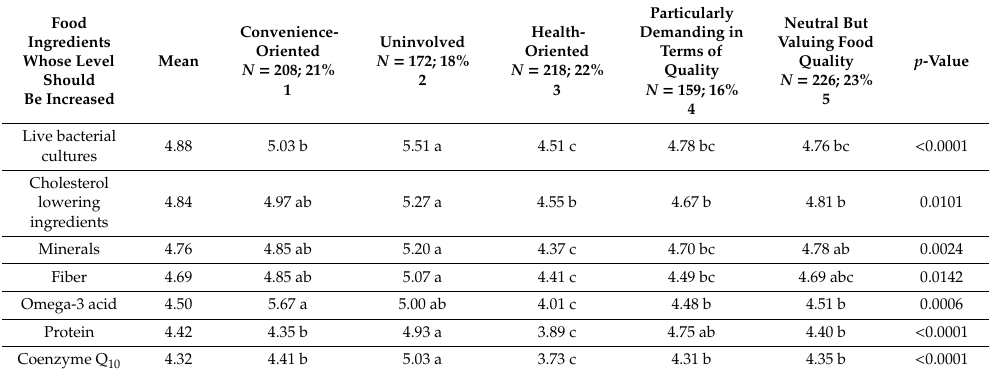
Table 5. Consumers (cid:48) opinion on increasing in dairy products the level of ingredients that have a positive impact on health.